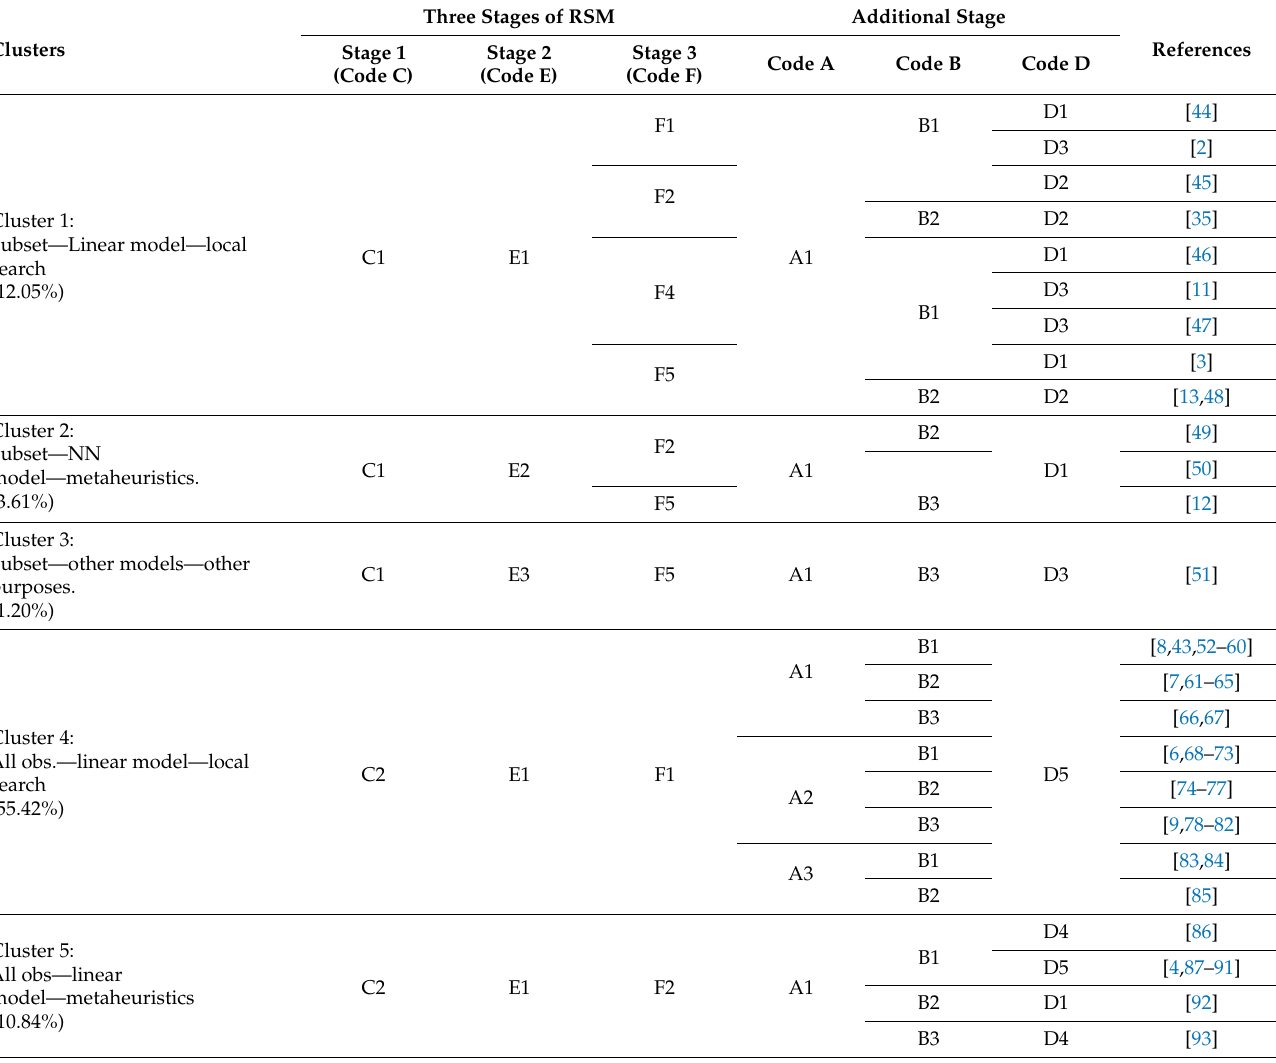
Table 6. References for Figure